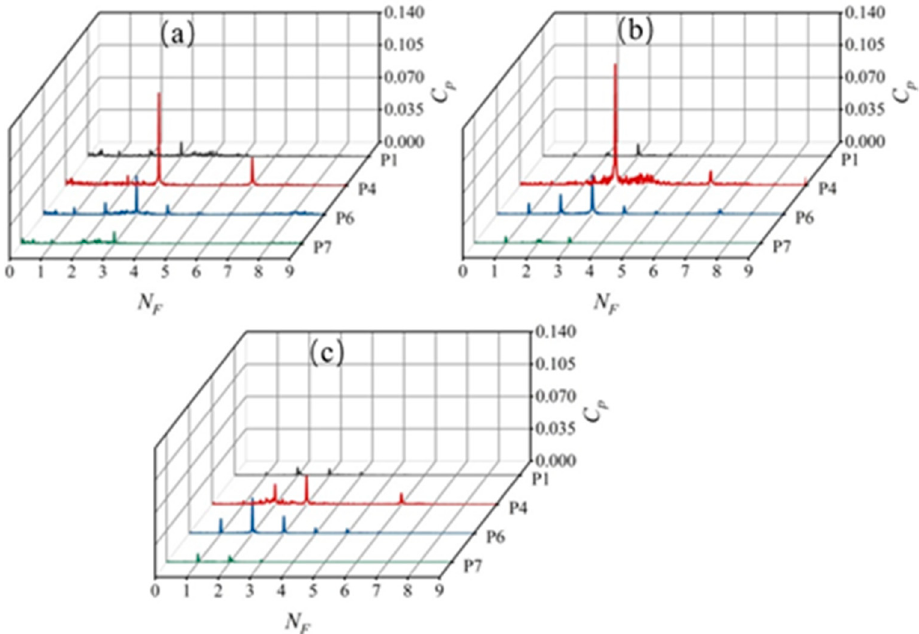
Figure 9. Frequency domains of pressure fluctuations under different flowrate conditions: ( a ) 0.6 Q d ; ( b ) 1.0 Q d ; ( c ) 1.1 Q d .